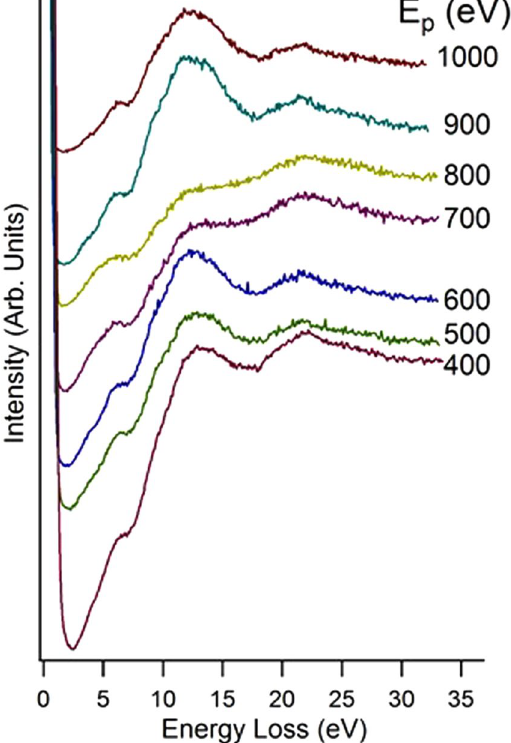
Figure 8. EELS spectra acquired at different values of the primary energy E p